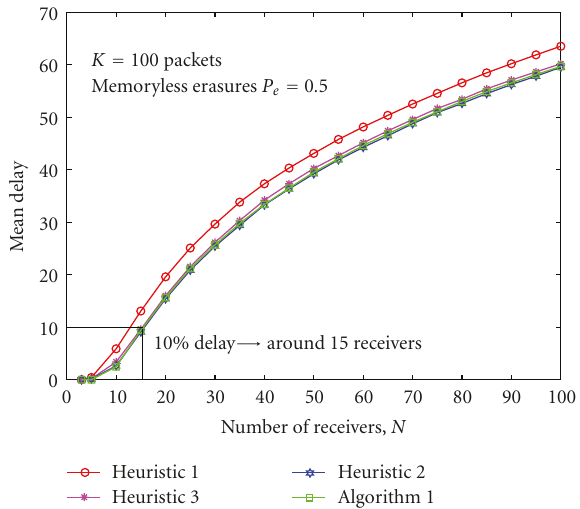
Algorithm 1 using minimum coding Algorithm 1 using maximum coding Figure 4: The e ff ect of post processing on mean delay. Whenever Algorithm 1 returns multiple solutions, minimum amount of coding should be chosen. Heuristic 1 is shown for